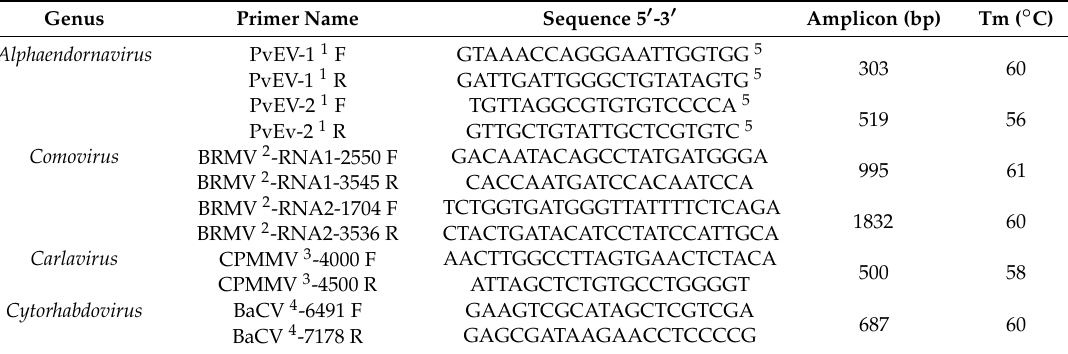
Table 1. Virus-specific primers sequences used for